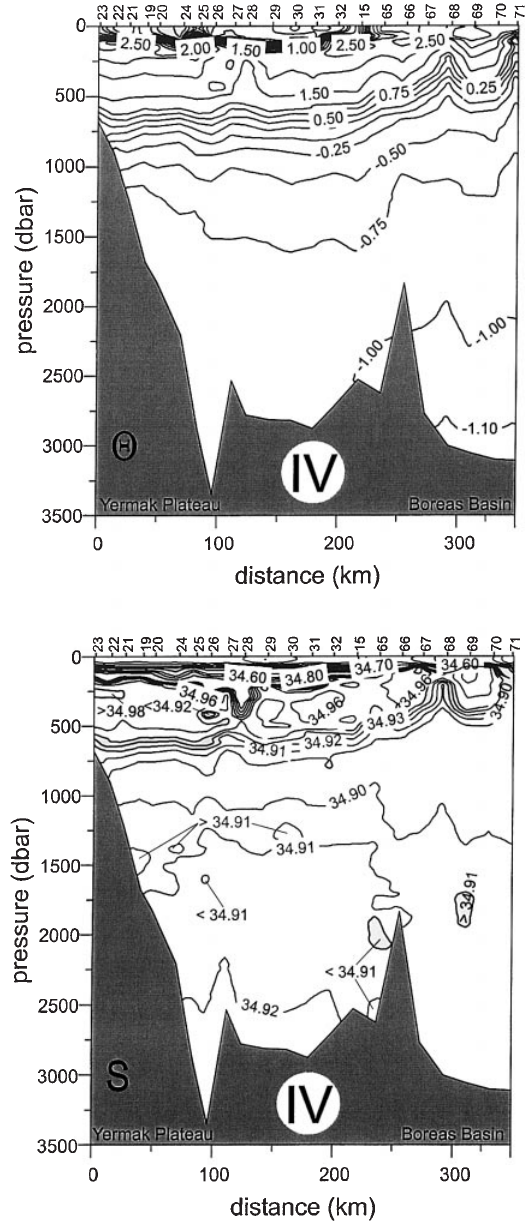
Fig. 6. Distribution of potential temperature and salinity on the north-south section IV along the axis of Fram